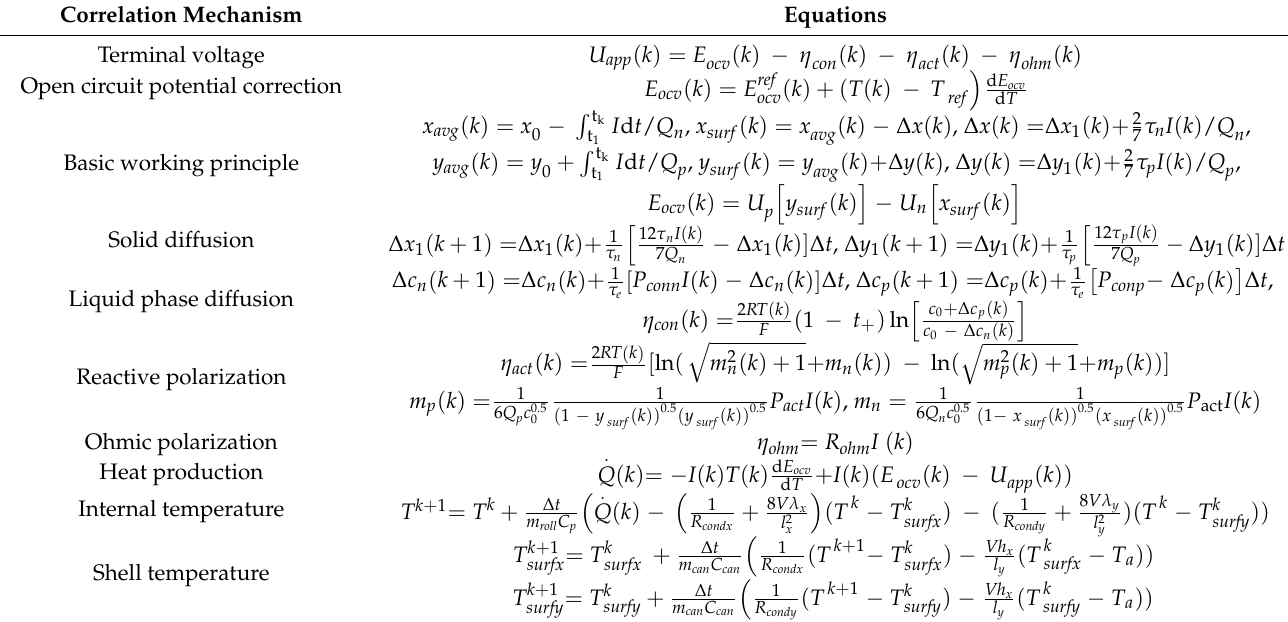
Table 1. Numerical equations of the model.